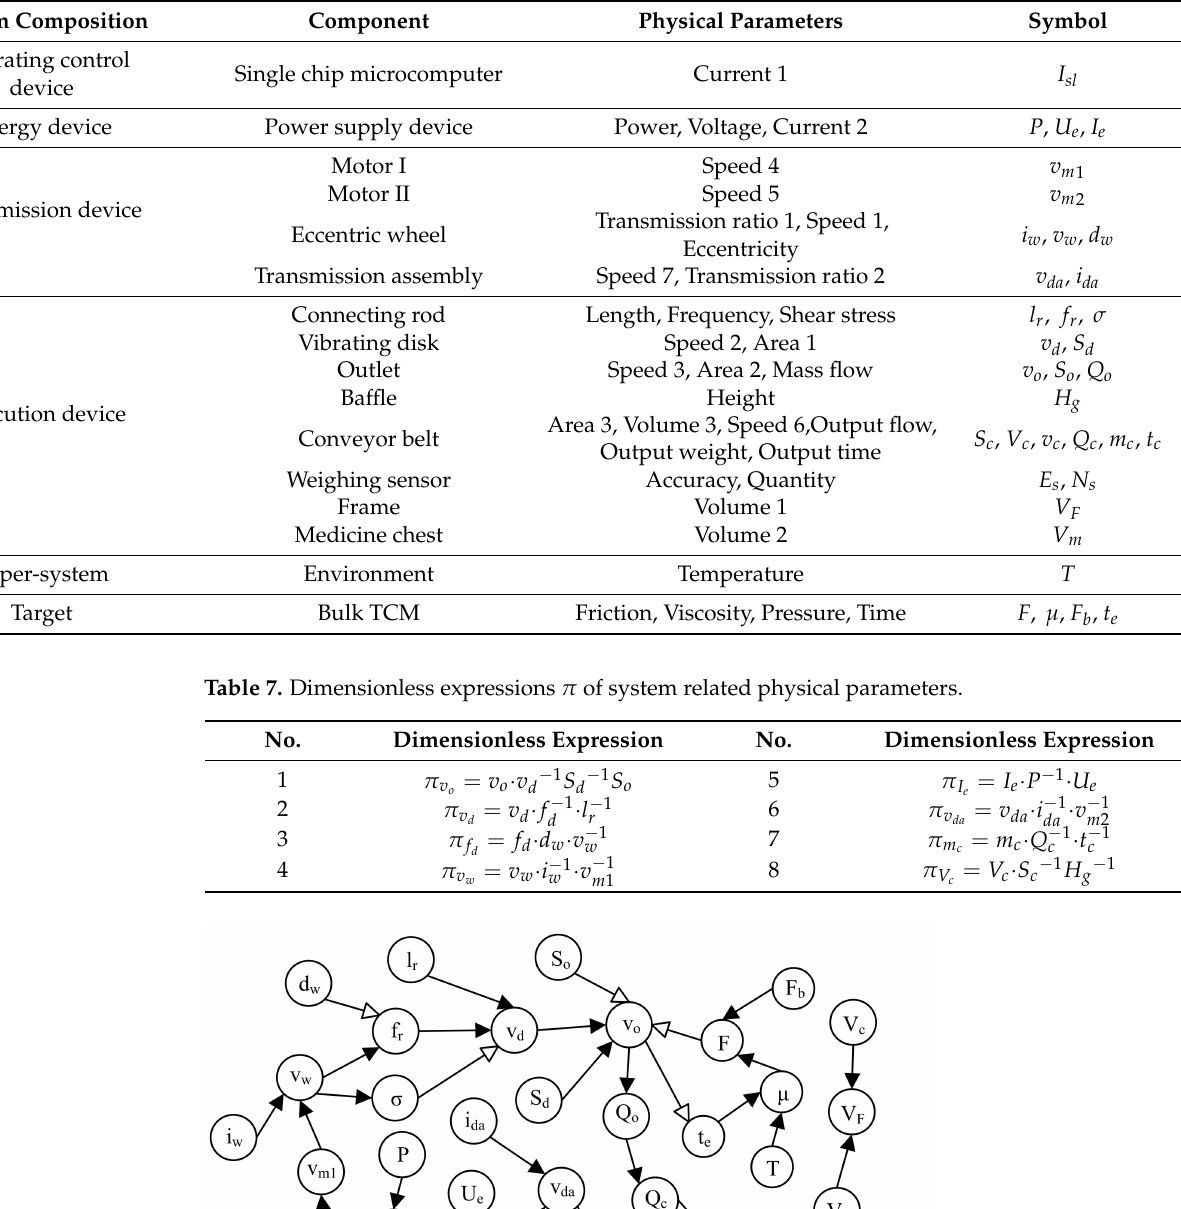
Table 6. Physical parameters related to components in the function model.